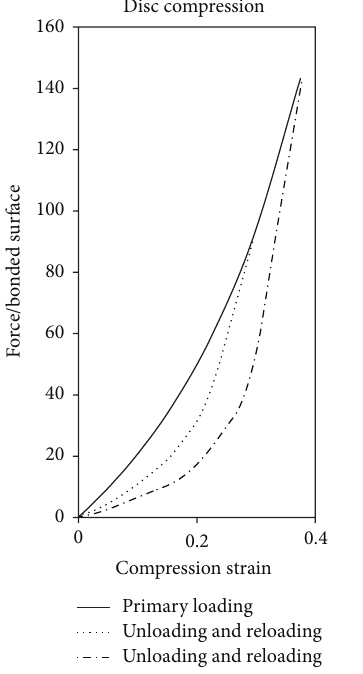
Figure 3: Load-compression curves of bonded disc.